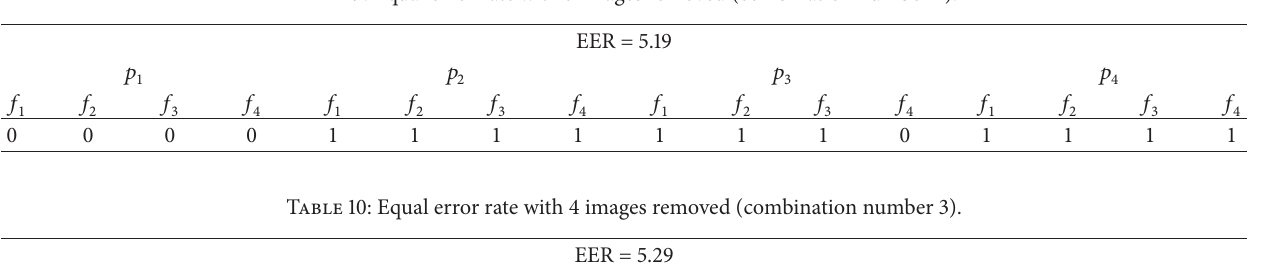
Table 9: Equal error rate with 5 images removed (combination number 2).